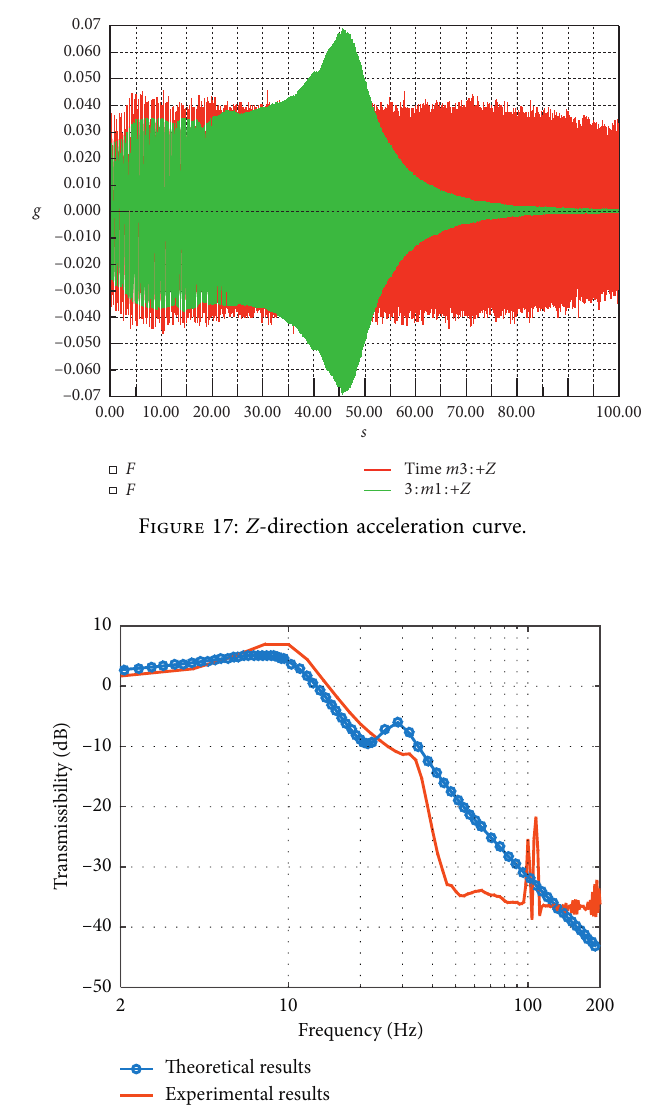
Figure 18: X -direction vibration isolation system transmission rate.